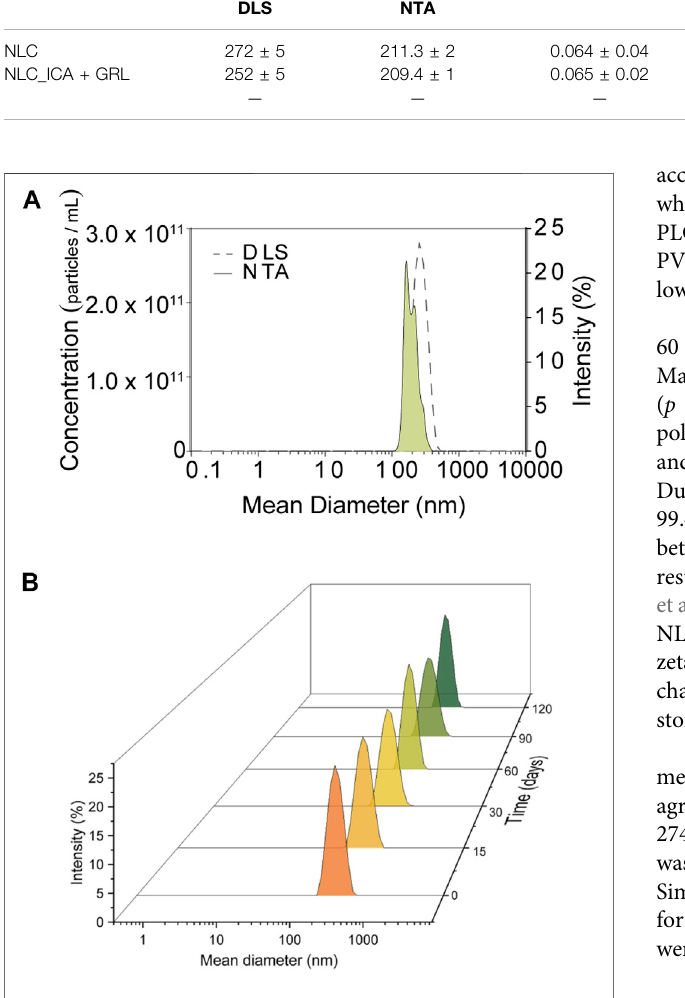
( Figure 1A ). The size distribution pro fi le analyzed for 120 days showed good stability of the system, with no signi fi cant differences ( p < 0.05) in formulation homogeneity ( Figure 1B ). The negative ZP values were due to the type of surfactant used (PVA), with the stabilization mechanism being